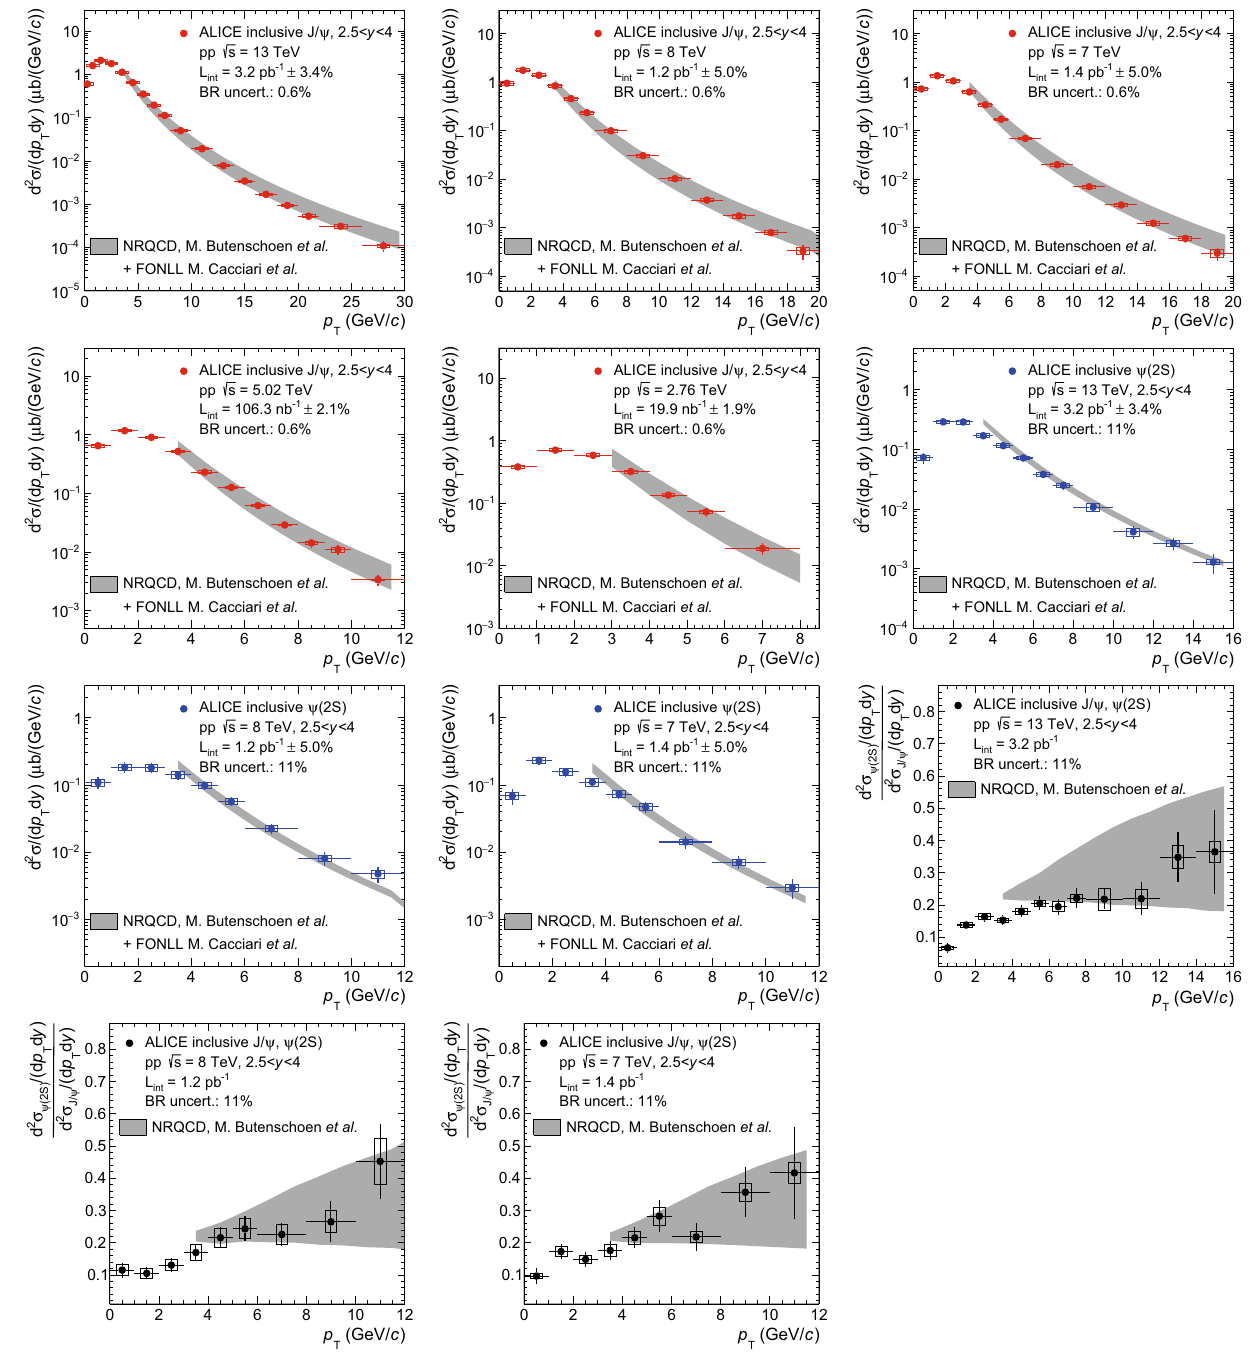
Fig. 10 Comparisons between ALICE J /ψ and ψ( 2S ) data and summed NRQCD and FONLL model calculations from [37,39]. The first five panels correspond to inclusive J /ψ production cross sections as a function of p t in pp collisions at